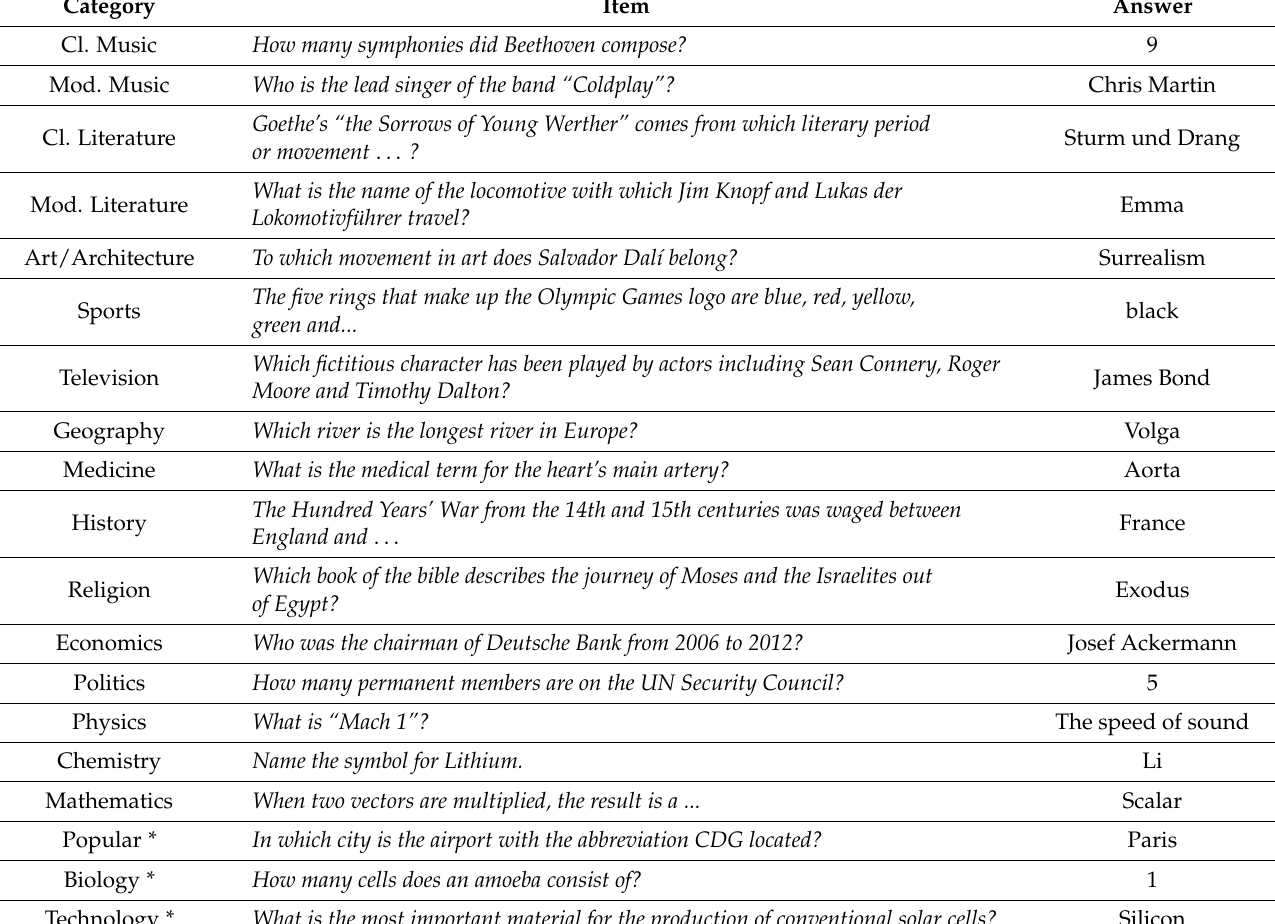
Table 2. Knowledge Categories and Example Items of the DoKnow